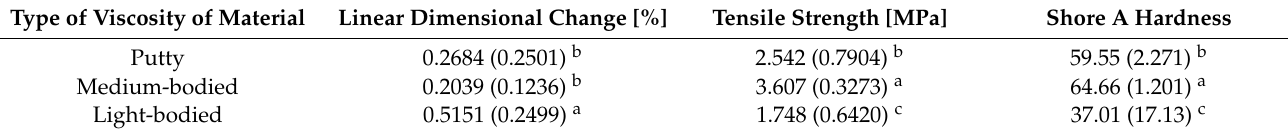
Table 3. Mean (SD) of linear dimensional change, tensile strength, and Shore A hardness for the materials of different types of viscosity; different superscript letters indicate the statistical significance ( p < 0.05) of differences between the studied